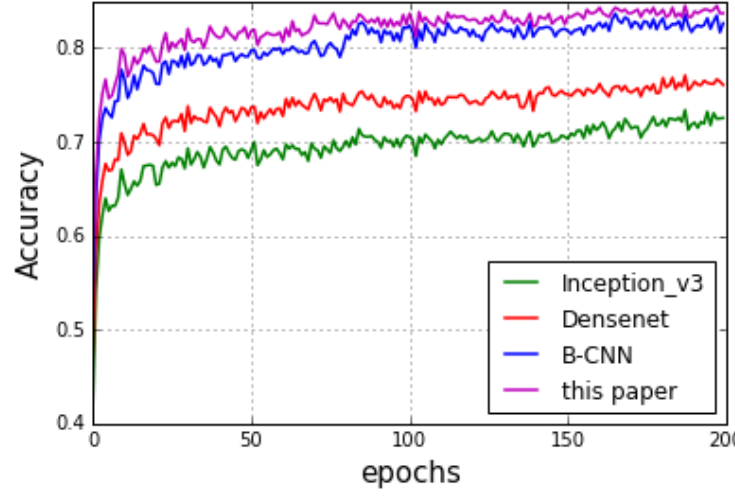
Figure 11. Accuracies of different networks on the CUB200-2011 dataset.